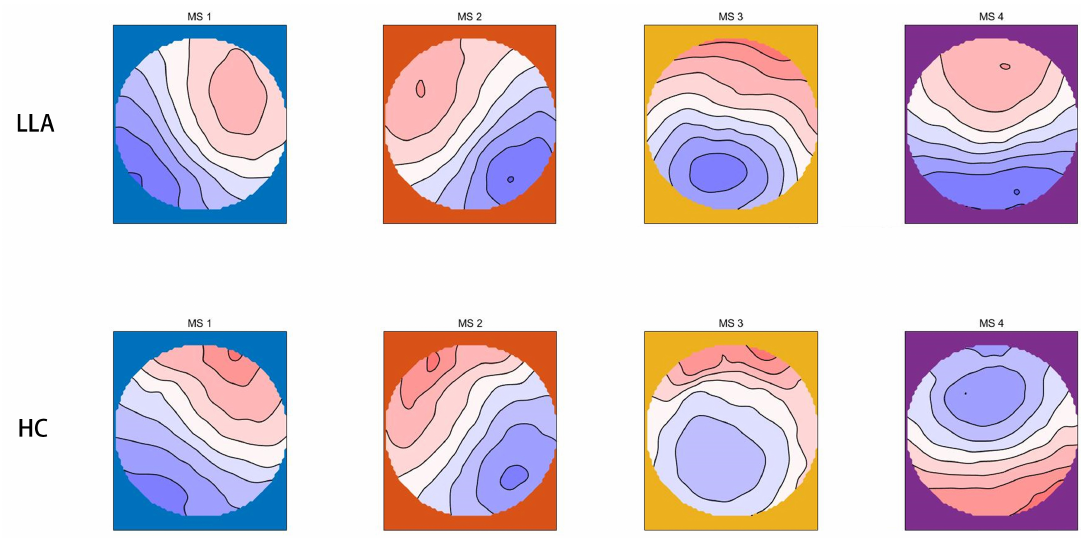
Fig. 1. Microstate topographic maps of patients with LLA and HC controls. MS1, MS2, MS3 and MS4 correspond to microstate classes A, B, C, and D, respectively. Koenig et al. [30] found that four microstates could explain around 79% of cortical activity.